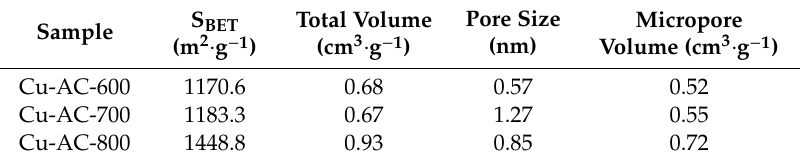
Figure 2. SEM images of the Cu-AC samples at different activation temperatures. Table 1. Specific surface area and pore size distribution of samples.